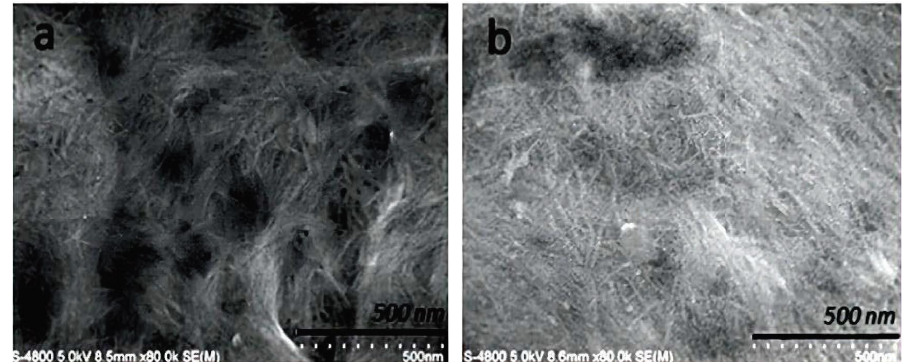
Figure 5: Te FESEM imaging of (a) rice straw CNCs (CNs-RS) with an average diameter is 11.6nm and (b) poplar wood CNCs (CNCs-PS) with an average diameter is 13.7nm [119]. Copyright and permission from Springer Nature-2019.